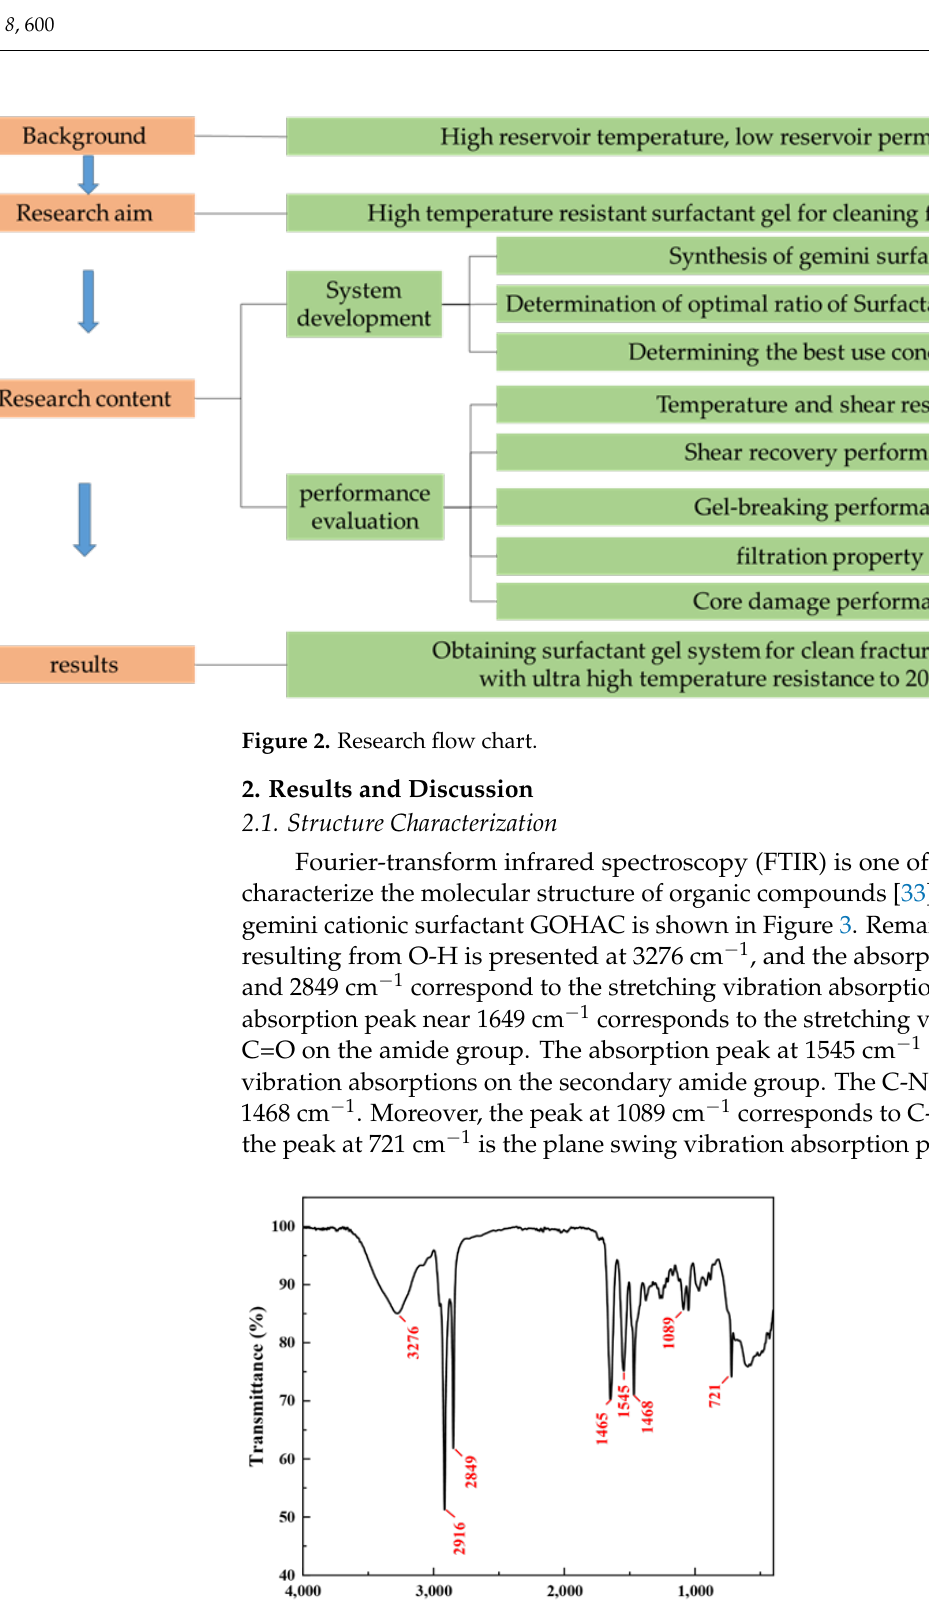
Figure 3. FTIR spectrum of GOHAC. 1 H NMR spectra are an important method to detect the structure of organic com- pounds, which is an important supplement to FTIR [34]. The 1H-NMR spectra of GOHAC surfactant are shown in Figure 4. The 1H-NMR (Methanol-d4) data are shown as follows: